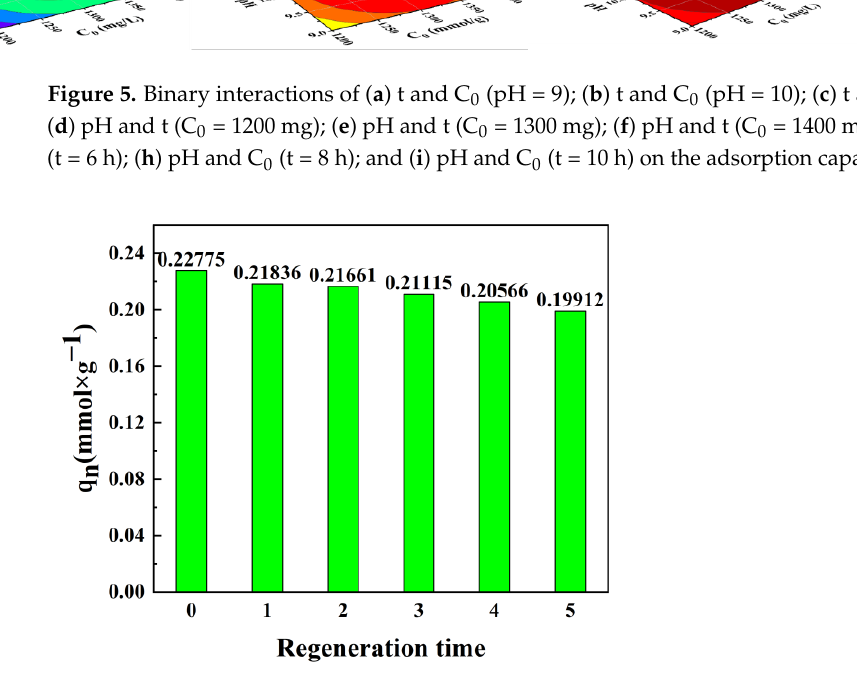
Figure 6. The adsorption capacity of the adsorbents after several times regeneration.